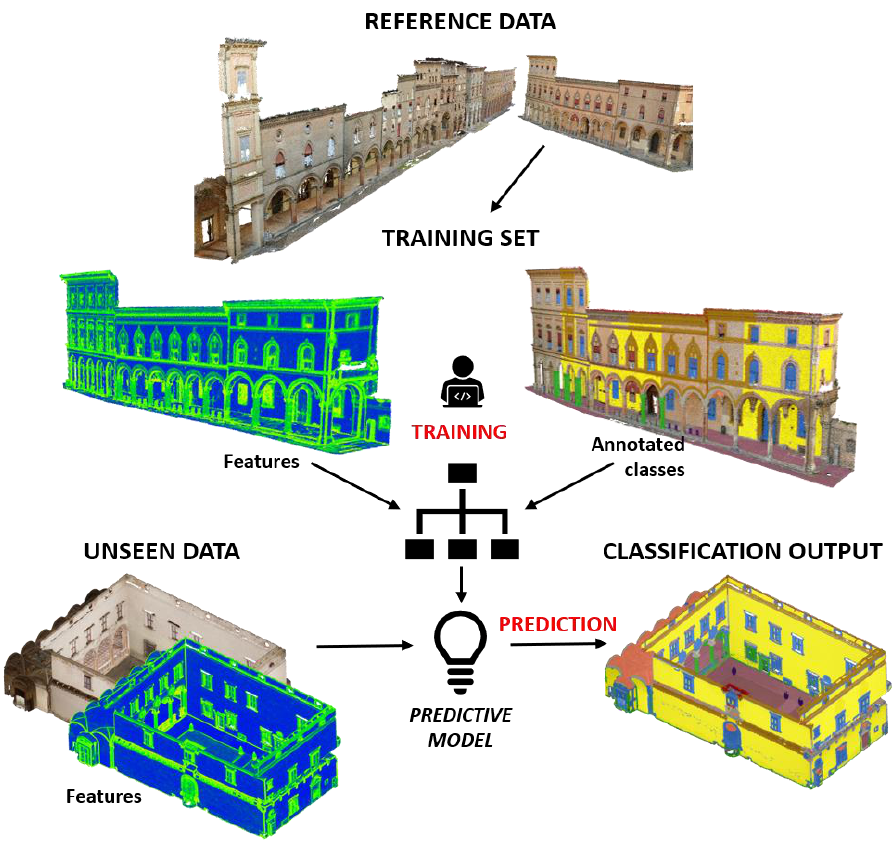
Figure 2. Three-dimensional (3D) point cloud classification process for unseen datasets. Some portions are extracted from the reference point cloud, manually annotated and enriched with selected features (Section 2.2). A random forest algorithm is then trained to generate a predictive model. This model is used to classify unseen scenarios.